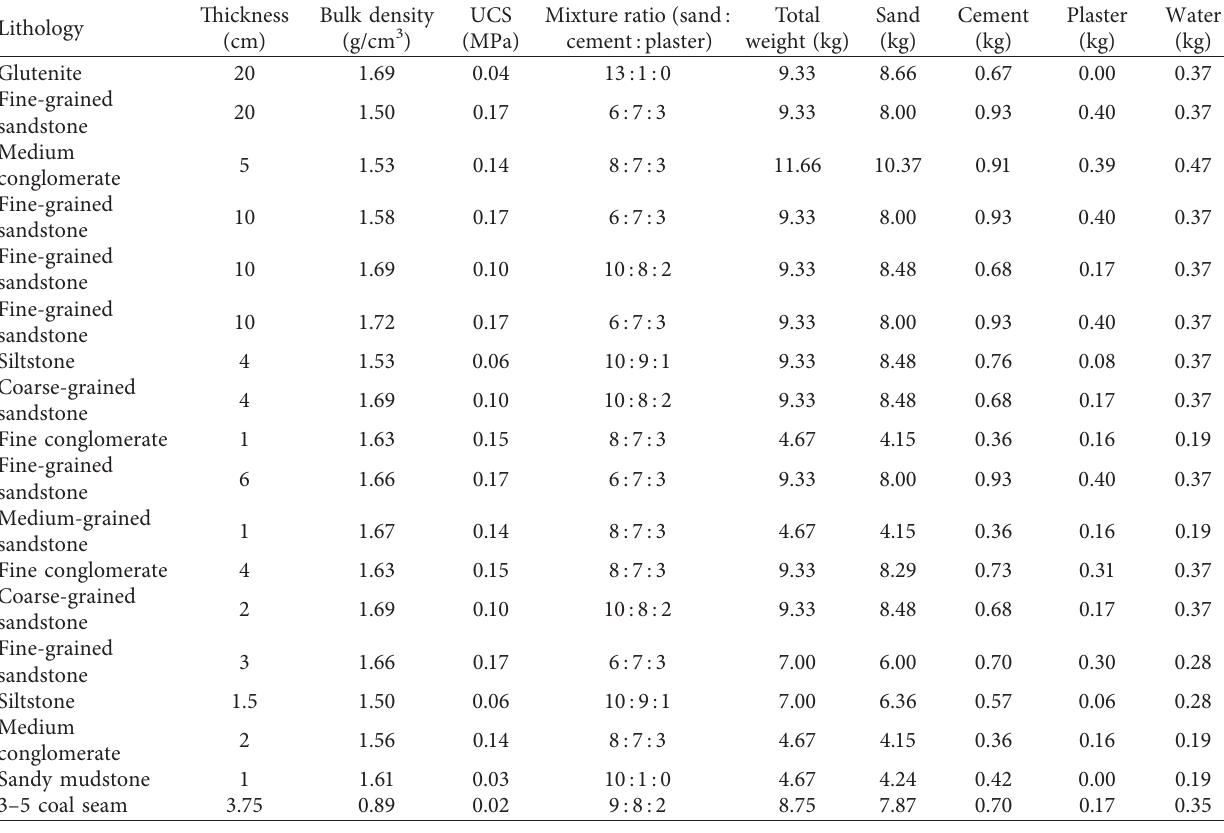
Table 3: Material mixture ratio and the parameters of the similar model.